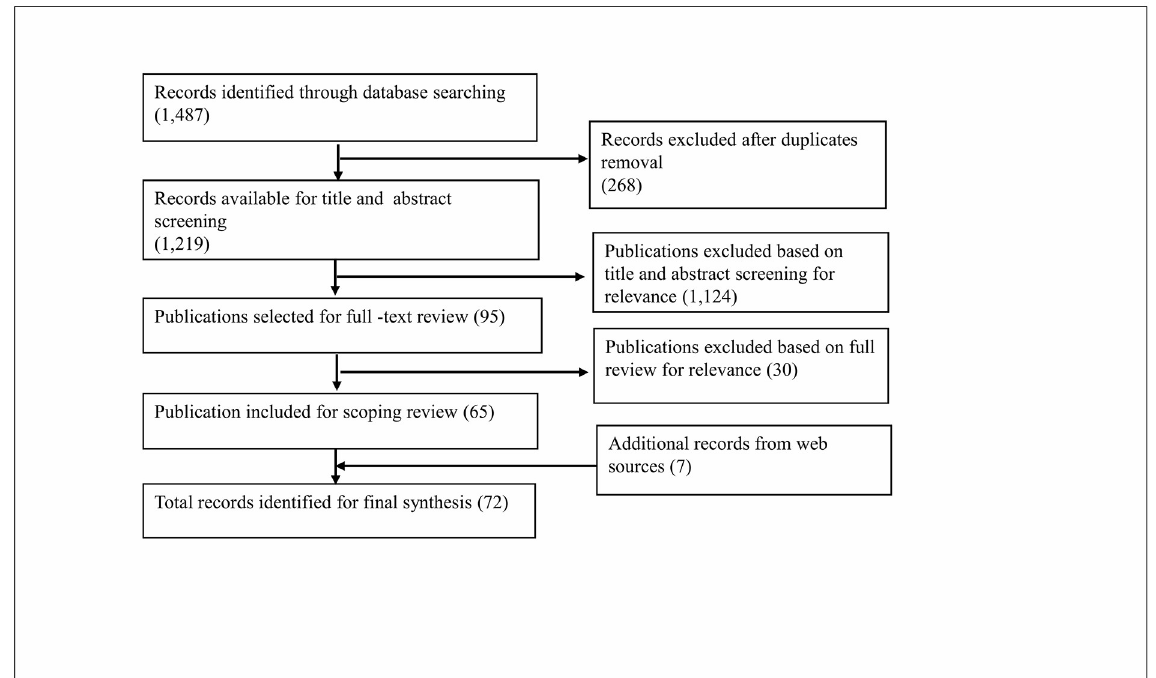
Fig 1. Flow diagram of search